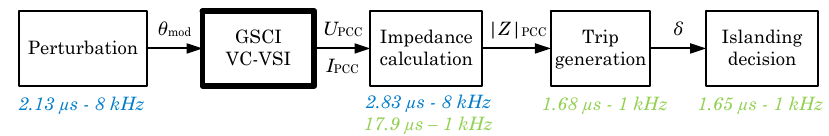
Figure 20. Impedance measurement operation